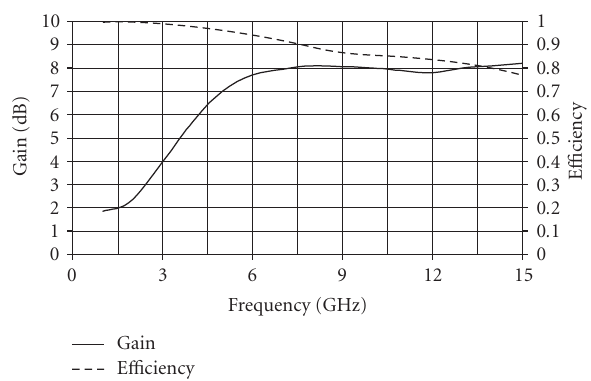
Figure 7: Variation of gain and e ffi ciency of a PEMA with 2 A = 4 . 8 cm and 2 B = 5 . 2 cm. 2 B = 5 . 2 cm, all the loops curl around the centre of the Smith chart, bringing them inside VSWR = 2 circle. This leads to increase in bandwidth beyond 5 GHz. For the fourth case of 2 A = 4 . 8 cm and 2 B = 5 . 2 cm, the PEMA was analysed up to 16